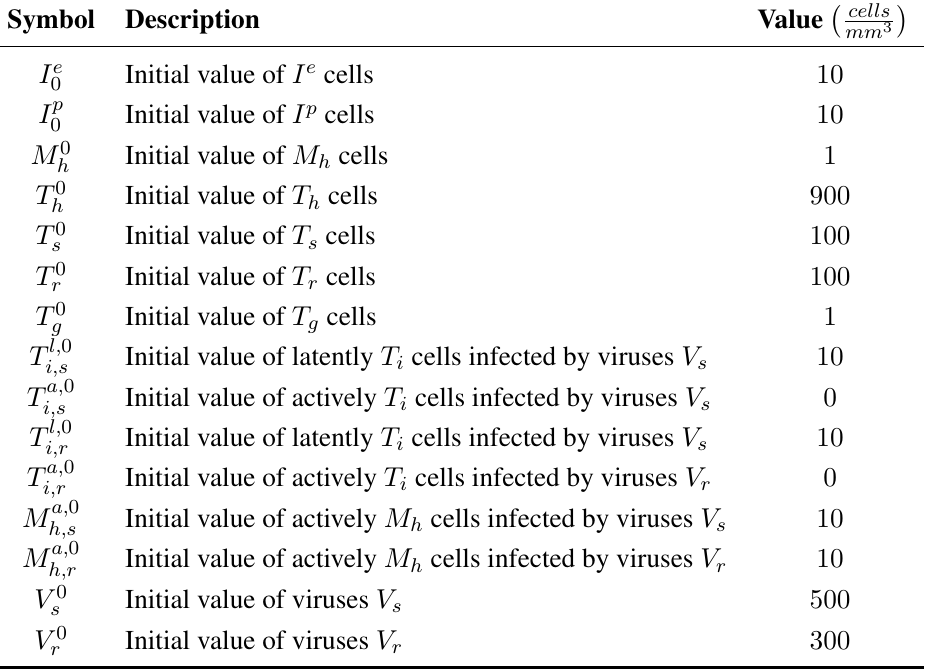
Table B4. Common boundary conditions at both